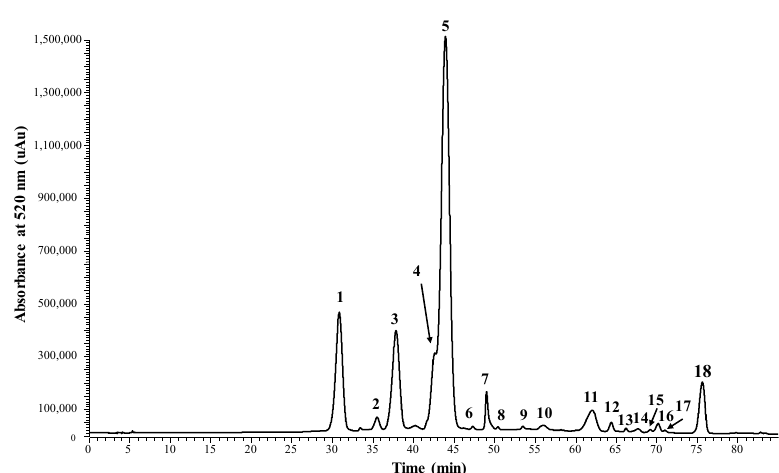
Figure 7. LC chromatogram recorded at 520 nm of the red grape must sample collected at the end of the alcoholic fermentation process (R-EF). 1, Dp-3-glc; 2, Cy-3-glc; 3, Pt-3-glc; 4, Pn-3-glc; 5, Mv-3-glc; 6, CarboxypyranoPn-3-glc; 7, CarboxypyranoMv-3-glc; 8, PyranoMv-3-glc; 9, CarboxypyranoMv-3- acetylglc; 10, Pt-3-acetylglc; 11, Mv-3-acetylglc; 12, Dp-3-coumglc; 13, CarboxypyranoMv-3-coumglc; 14, Mv-3-cafeyolglc; 15, Cy-3-coumglc; 16, Pt-3-coumglc; 17, Mv-3- cis -coumglc; 18, Mv-3- trans - coumglc.